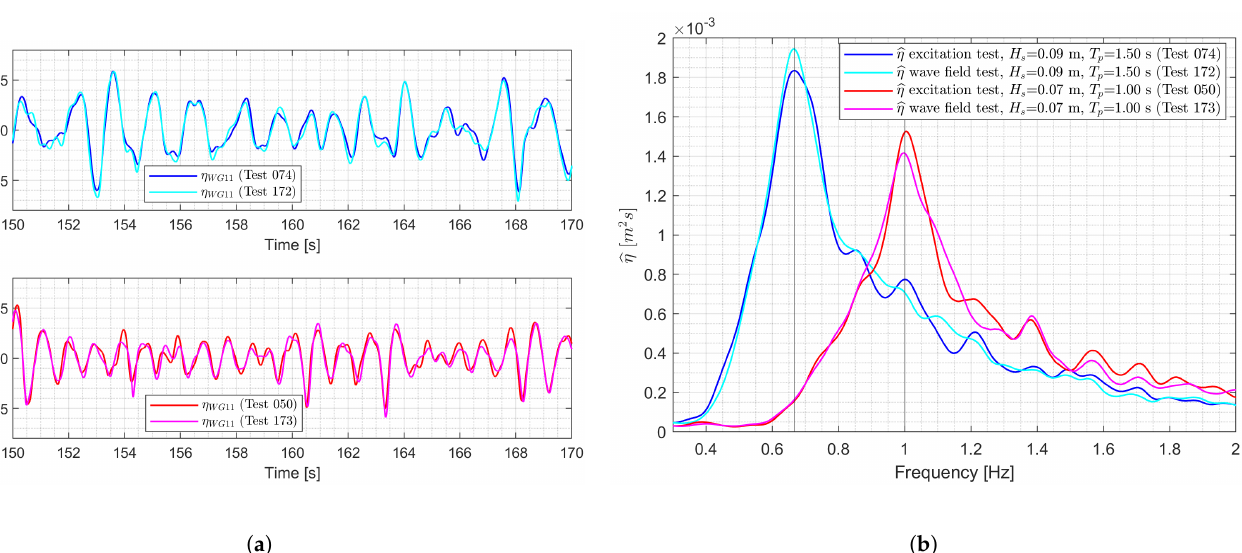
Figure 15. Wave excitation tests (Test_074 and Test_050) and wave field accuracy tests (Test_172 and Test_173): ( a ) η WG 11 time series; ( b ) (cid:98) η , frequency smoothened over a window of 30